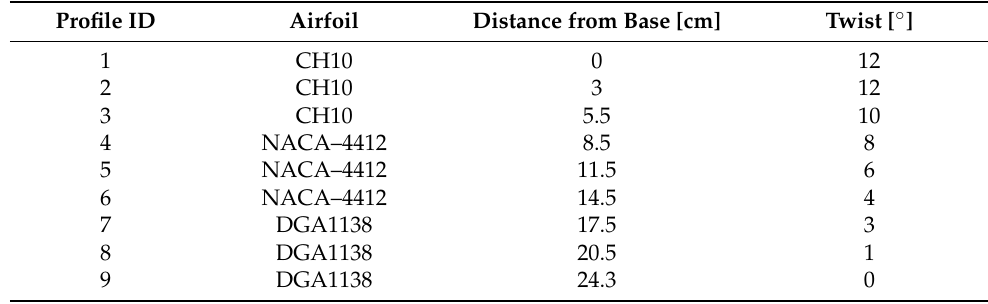
Table 2. Bio-inspired turbine blade Table 2. Bio ‐ inspired turbine blade characteristics.